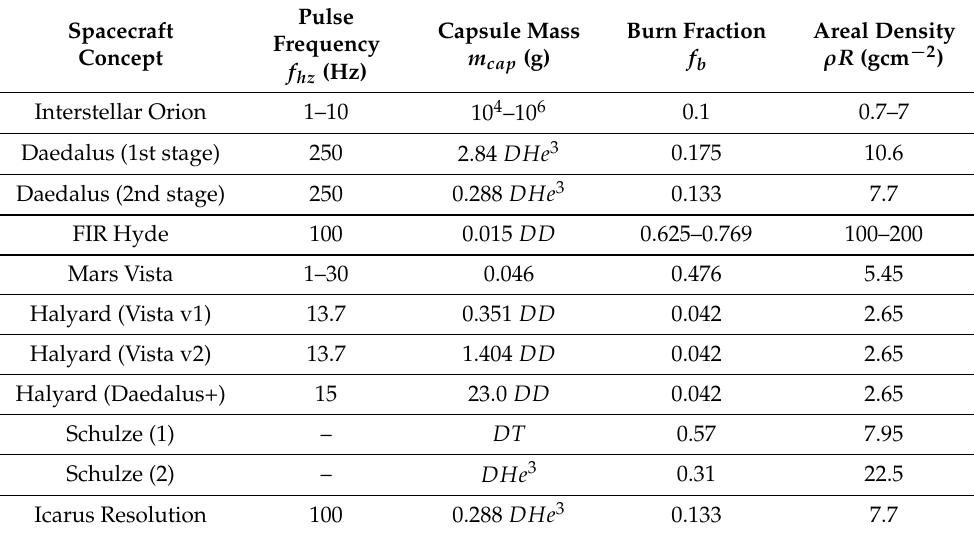
Table 6. Calculation of ICF capsule performance output parameters for different spacecraft concepts. Note that the value of f b for Orion is an assumed number since this is not